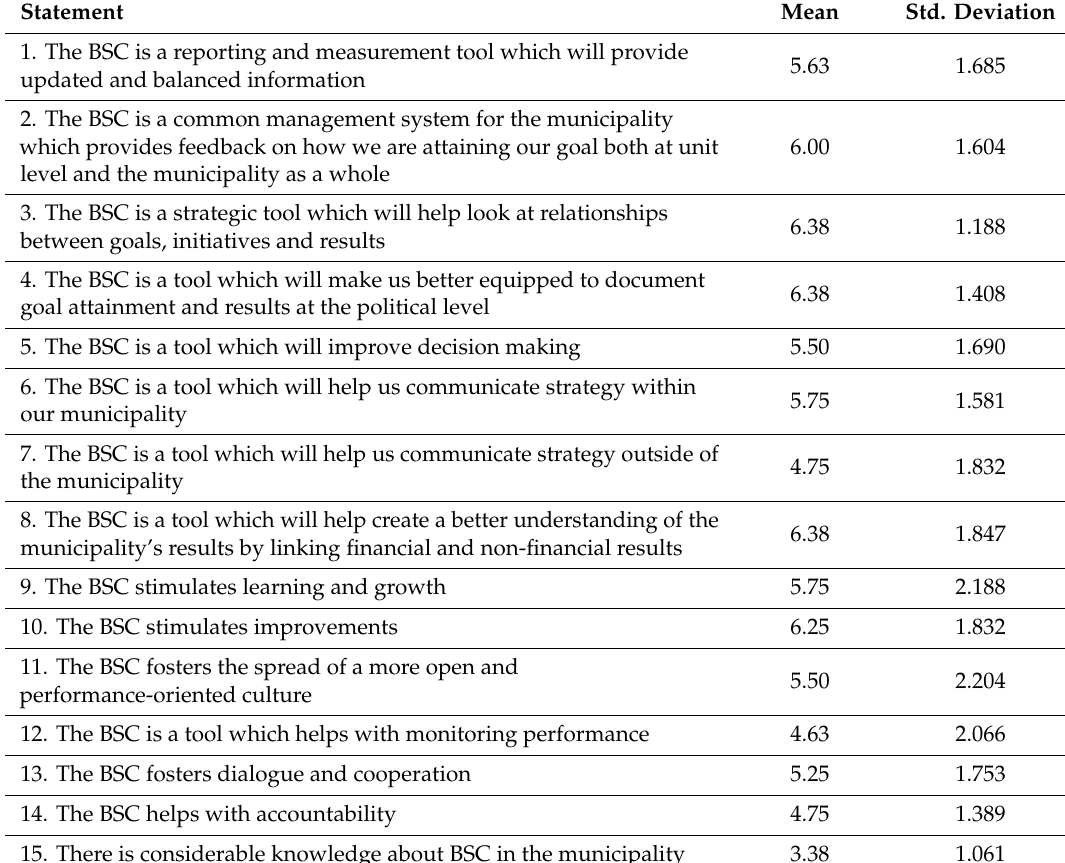
Table 13. Reasons for adopting the BSC (N = 8) [Scale: